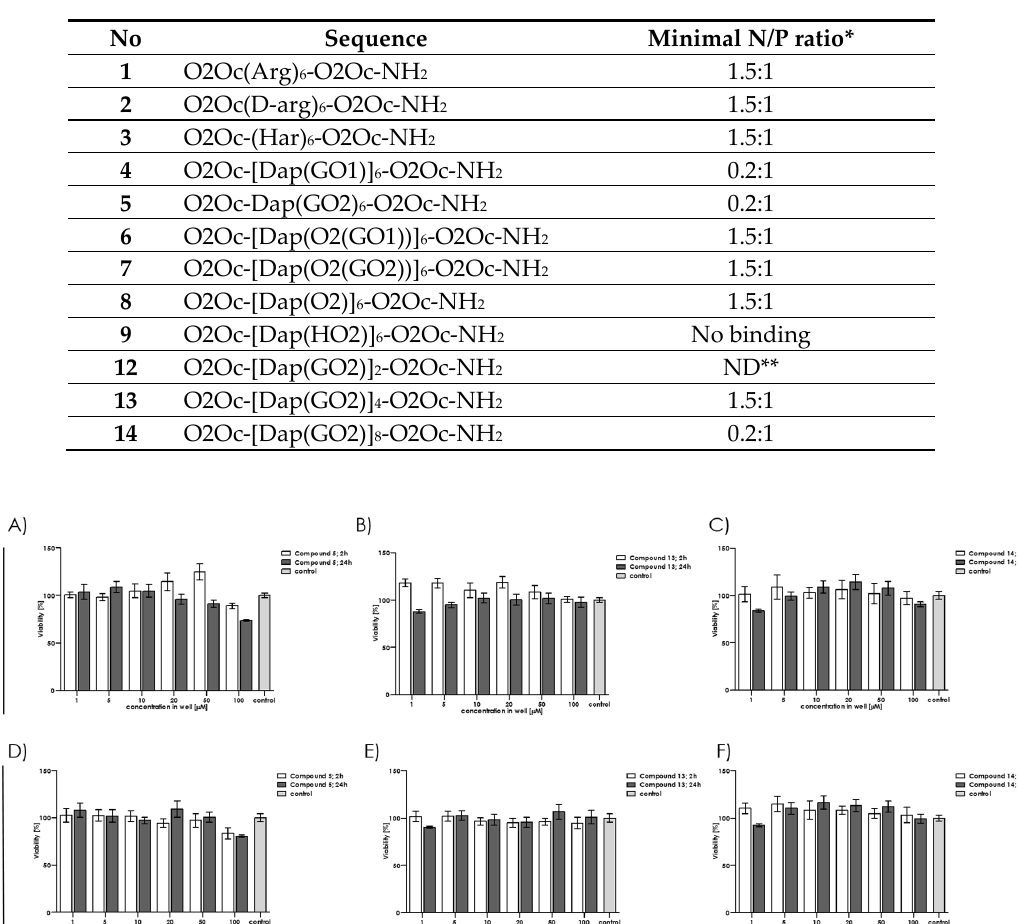
Table 1S. Minimal charge to ratio (N/P) of each compound for efficient complexation with DNA. *minimal N/P ratio resulting in effective complex formation based on EMSA. **ND ‐ no determinated